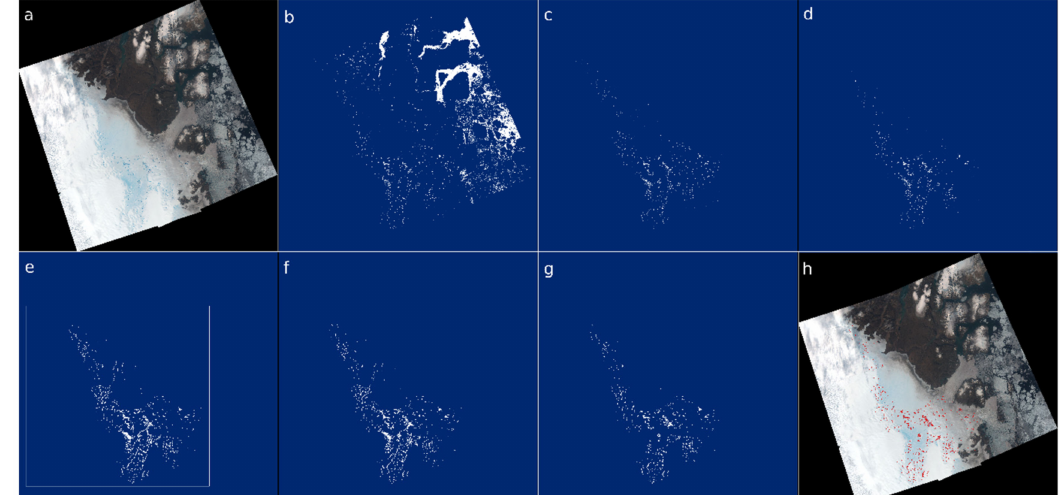
Figure 3. Postprocessing steps visualized by data of date 5 August 2019: ( a ) natural-color image (RGB, bands 4–3–2); ( b ) binary mask after thresholding; ( c ) binary mask cropped to the ablation area; ( d ) cropped mask after topographic shadow correction; ( e ) polygonized binary mask (with automatically created bounding box); ( f ) polygonized mask after dissolving; ( g ) lake polygons after cropping with topographic sinks; ( h ) lake polygons ( g ) over the true-color image ( a